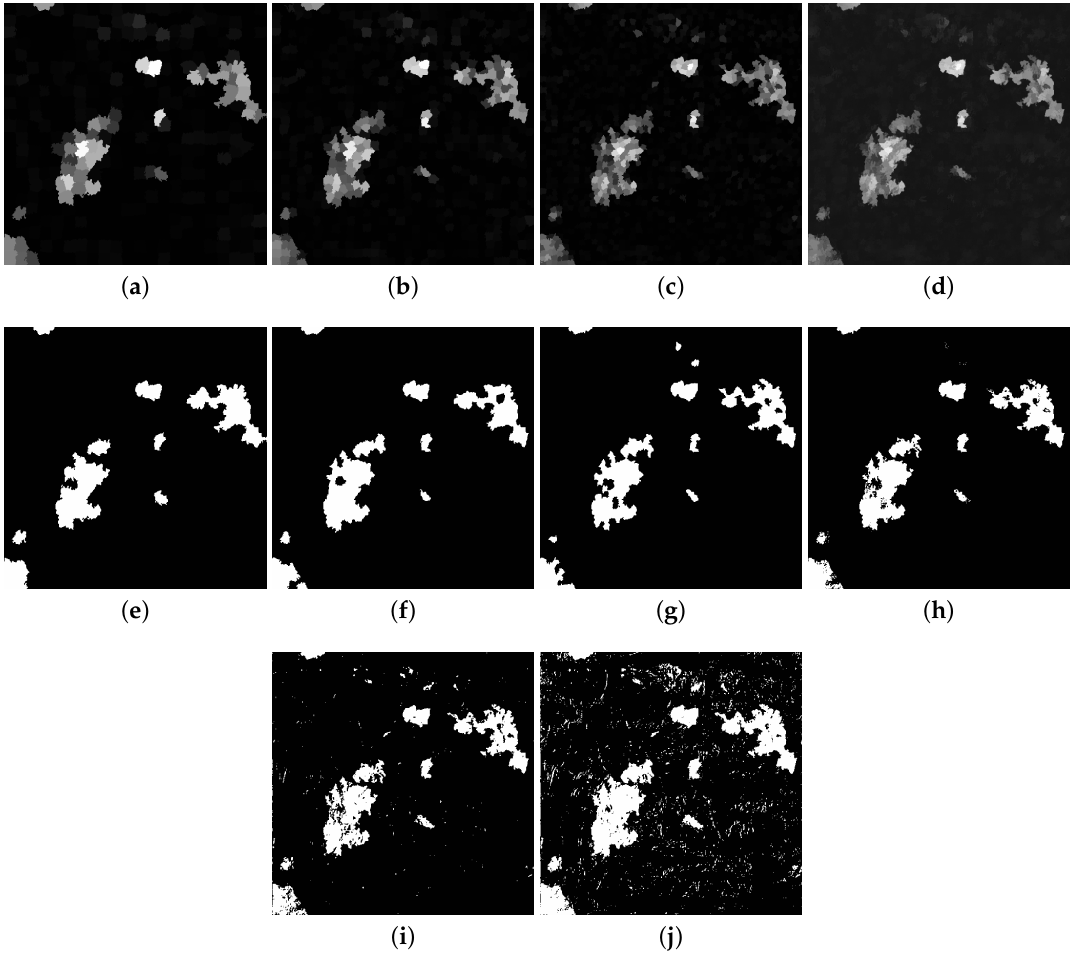
Figure 4. Results of saliency detecion and change detection for Mexico dataset. ( a – c ): Saliency map at scale 500, 1000, 2000, respectively. ( d ) Fused saliency map. ( e – h ): Change maps by K-means on ( a – d ), respectively. ( i ): Change map by K-means on DI. ( j ): Change map by EM-Bayes.